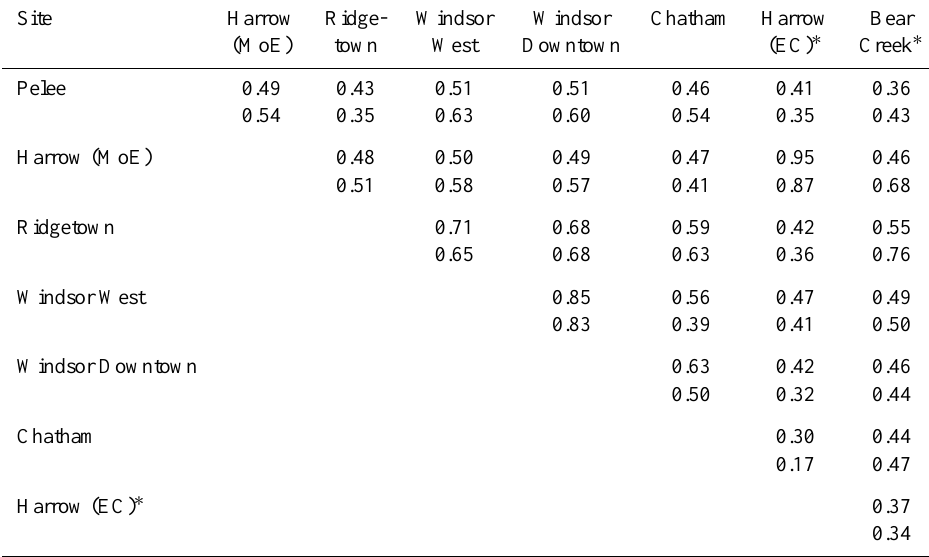
Table 1. Correlation (Pearson R ) between NO 2 measurement sites during the BAQS-met campaign (1 June to 10 September, 2007). The first row for each location represents the correlation between hourly measurements while the second represents correlation between daily measurements. All monitors not marked with a ∗ were heated molybdenum converted chemiluminescence monitors while those marked with a ∗ were photolytically converted chemiluminescence monitors.